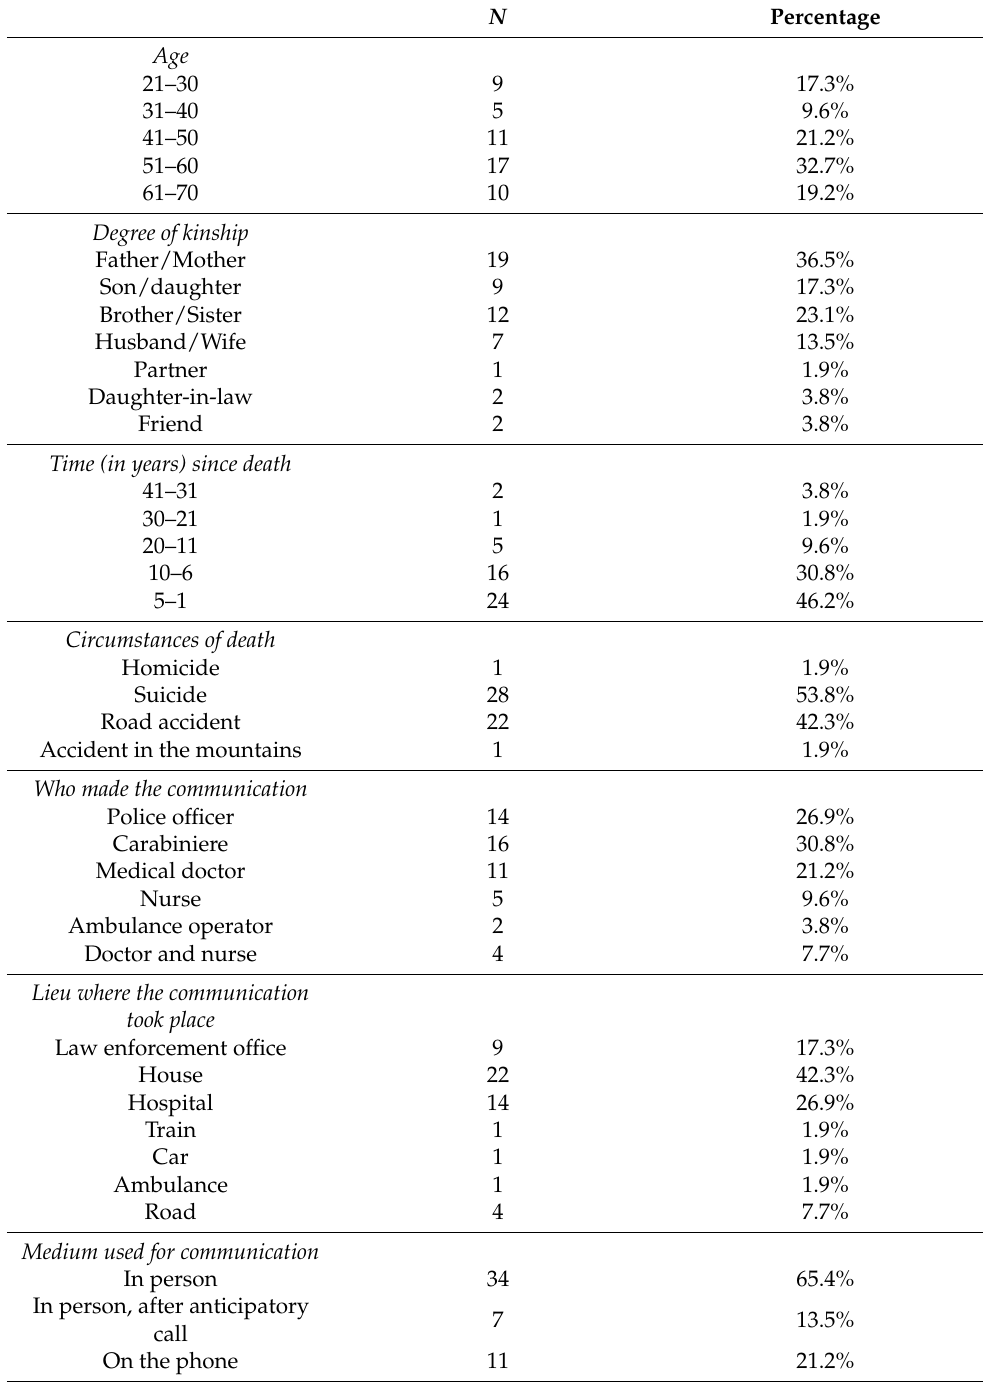
Table 2. Age, degree of kinship, time since death, circumstances of death, who made the communica- tion, lieu where the communication took place, and medium used for